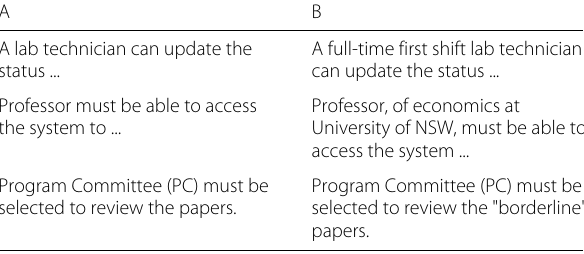
Table 2 Examples of the synthesized natural language policies A B A lab technician can update the status